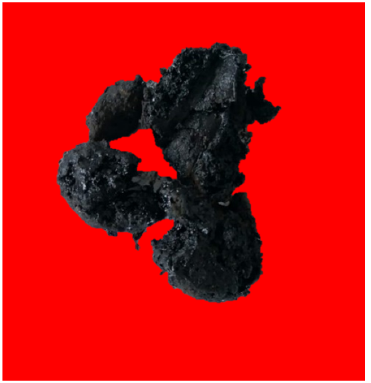
Figure 3. Photograph of the wellhead blockage in Well DH231 .